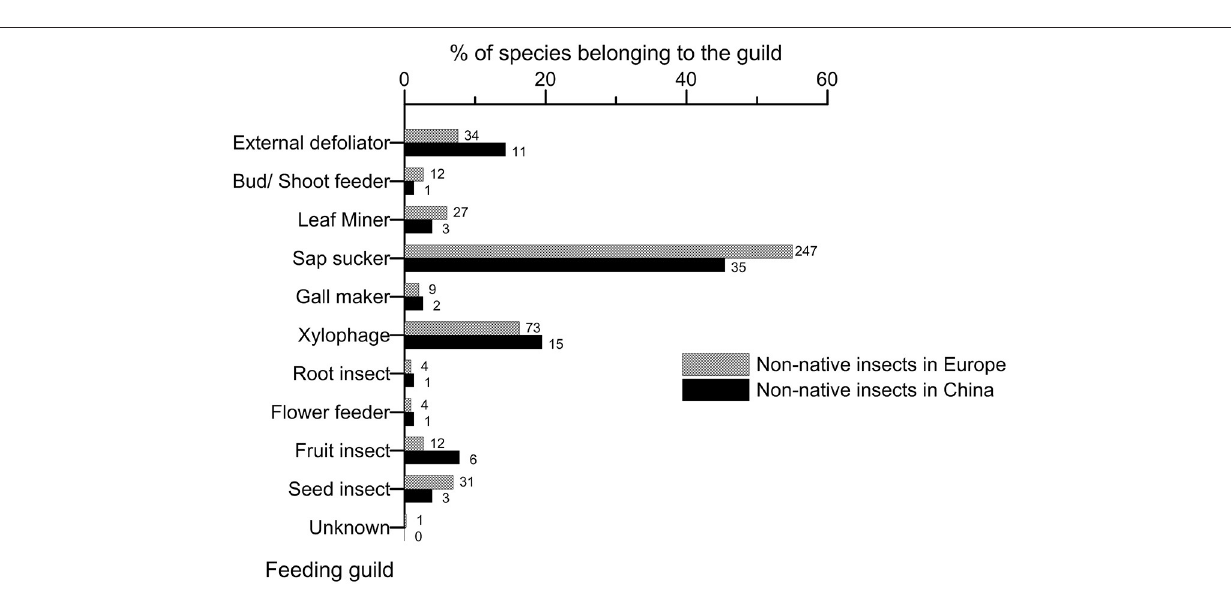
FIGURE 5 | Comparison of the feeding guild shown by the non-native species associated to woody plants having established in Europe and China up to 2019. The number on the right of each bar indicates the total number of non-native species observed per guild. Note that a species may belong to several guilds depending on its development